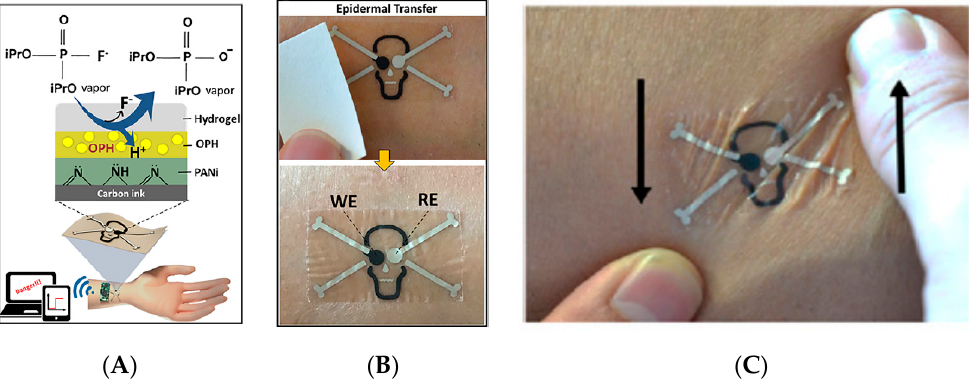
Figure 33. ( A ) Schematics of the potentiometric tattoo sensor working mechanism showing organophosphate hydrolysis on the OPH-modified electrode. Protons are released and protonate the polyaniline (PANi) layer. The data are transmitted wirelessly. The Ag/AgCl reference electrode is protected by a polyvinylbenzene (PVB) membrane containing NaCl. ( B ) Sensor transfer to the skin. ( C ) Resistance of the tattoo to mechanical strains. Reproduced from [96] with permission. © 2018 Elsevier B.V. All rights